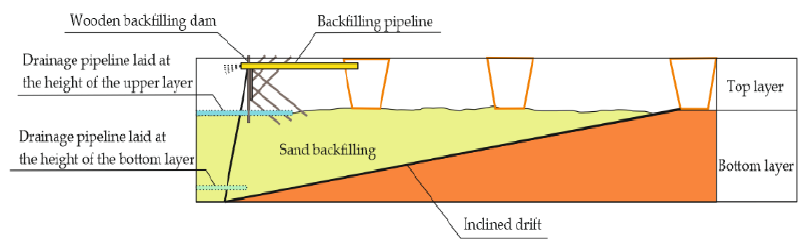
Figure 16. Backfilling in the inclined drift.